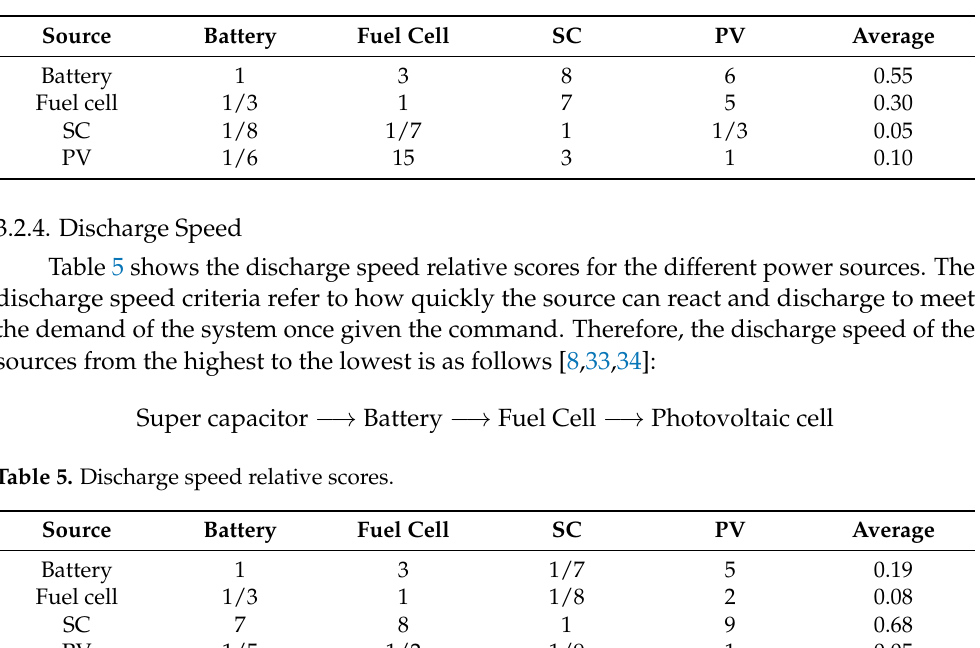
Table 4. Duration relative scores.